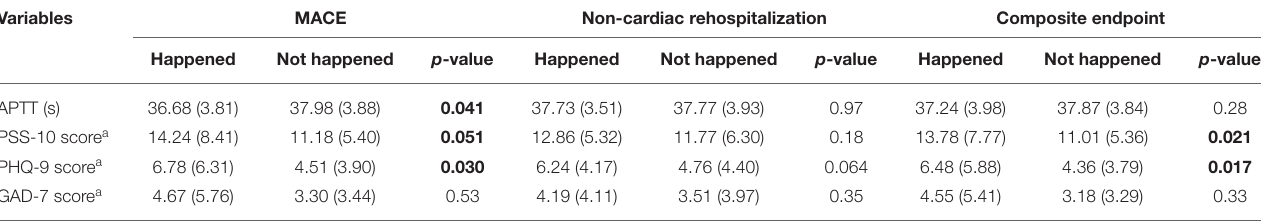
TABLE 4 | Comparison of APTT, PSS-10, Patient Health Questionnaire (PHQ-9), Generalized Anxiety Questionnaire-7 Scale (GAD-7) scores for different clinical outcomes. Variables MACE Non-cardiac rehospitalization Composite endpoint Happened Not happened p -value Happened Not happened p -value Happened Not happened p -value APTT (s)